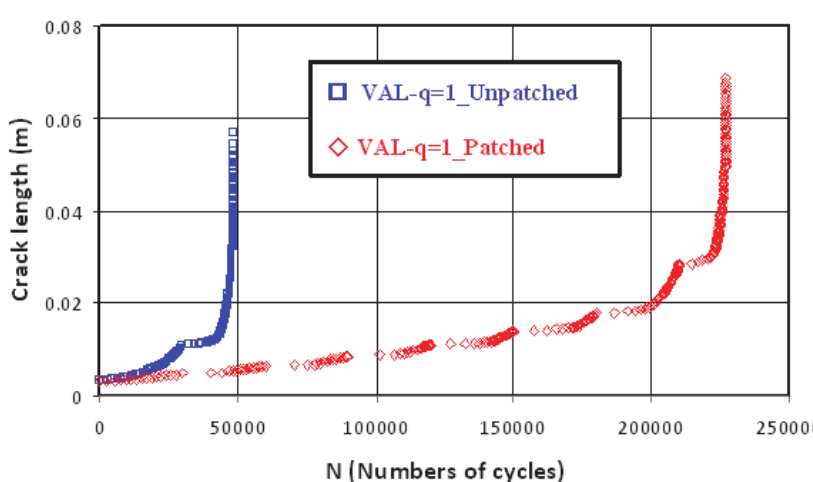
Figure 7: Influence of composite patch repair on fatigue life under variable amplitude loading (ORL=2.4)